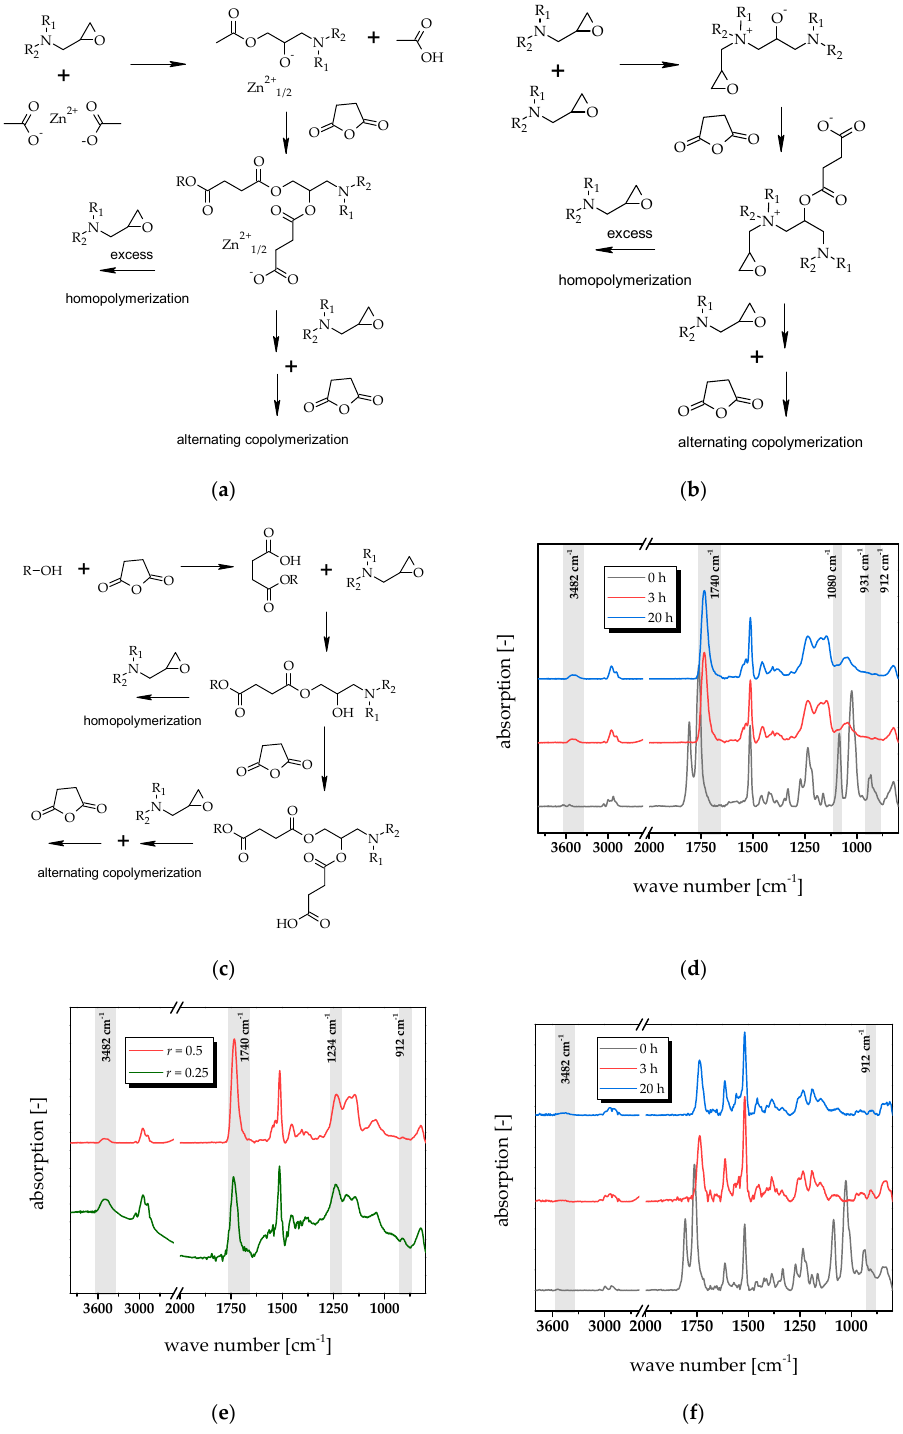
Figure 2. Mechanism of the ring opening reaction of epoxies with anhydrides in the presence of ( a ) zinc salts and ( b ) tertiary amines as catalysts or ( c ) without catalyst. ( d ) FT-IR spectra of catalysed 3-DGOA / glutaric anhydride systems cured with r = 0.5, prior to and after curing at 120 ◦ C for 3 and 20 h. ( e ) FT-IR spectra of catalysed 3-DGOA / glutaric anhydride systems as a function of the stoichiometric ratio, after curing at 120 ◦ C for 20 h. ( f ) FT-IR spectra of catalysed 4-DGA / glutaric anhydride systems cured with r = 0.5, prior to and after curing at 120 ◦ C for 3 and 20